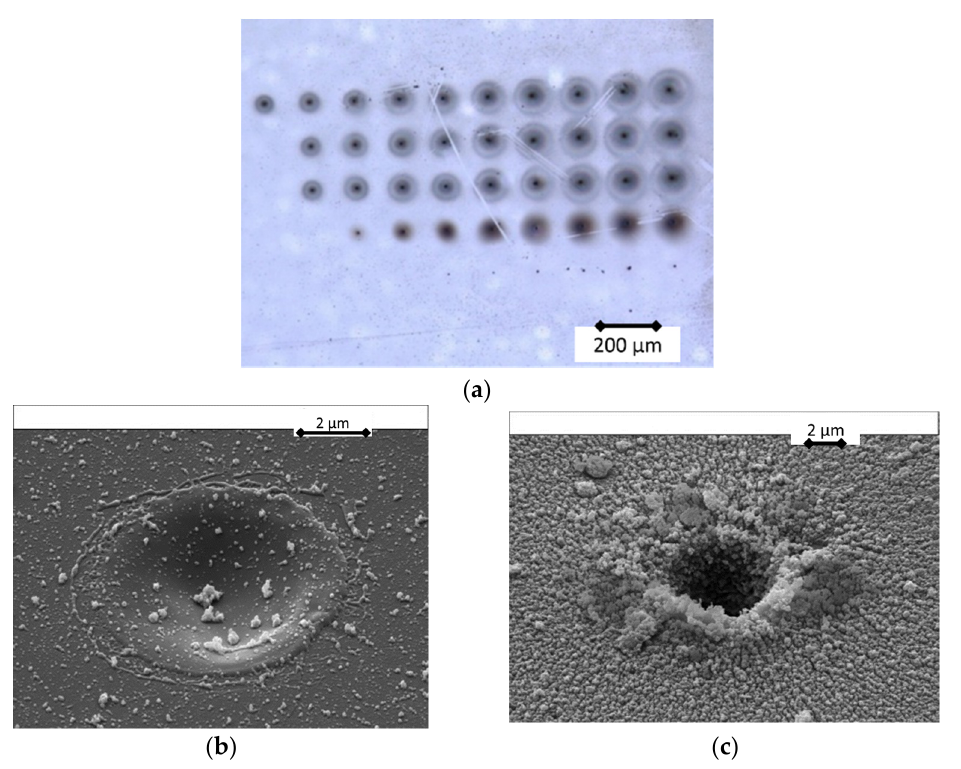
Figure 4. ( a ) Optical micrograph of the laser-modified sites on the surface of diamond, ( b ) SEM micrograph for surface modification of diamond at 10 pulses at 72 Jcm − 2 , and ( c ) SEM micrograph for surface modification of diamond at 50,000 pulses at 72 Jcm − 2 .